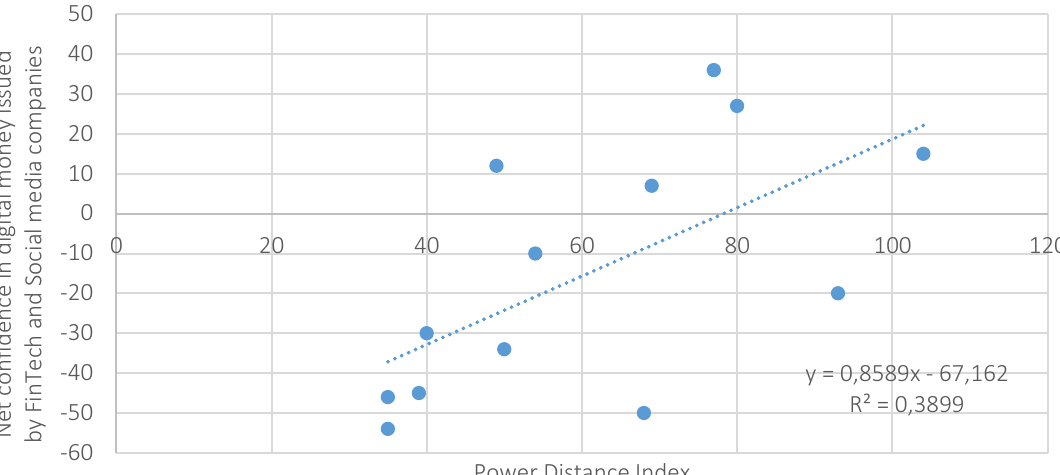
Figure B3. Confidence in CВDC and social trust